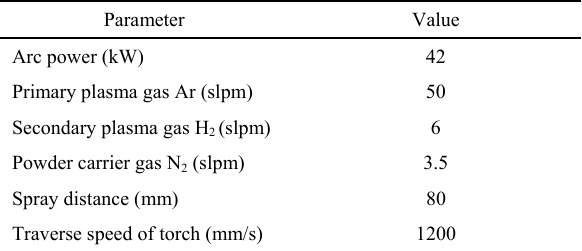
Fig. 2 Surface morphology of 7YSZ